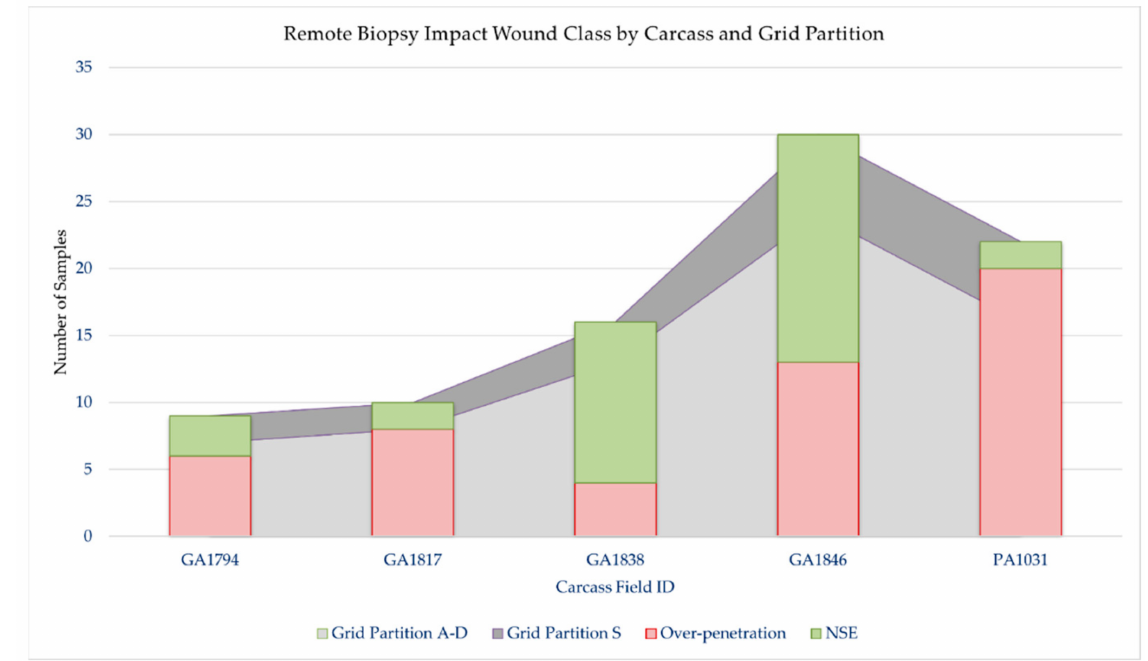
Figure 4. Remote biopsy wound classification for each carcass by grid partition. Grid partitions on each carcass were A, B, C, D, and S. Grid partitions A–D were defined as non-target areas and S was defined as the target area of each carcass. OP = over-penetration, defined as a wound penetrating through the subdermal fascia into muscle tissue; NSE = no visible subdermal effect, defined as a wound with no over-penetration.